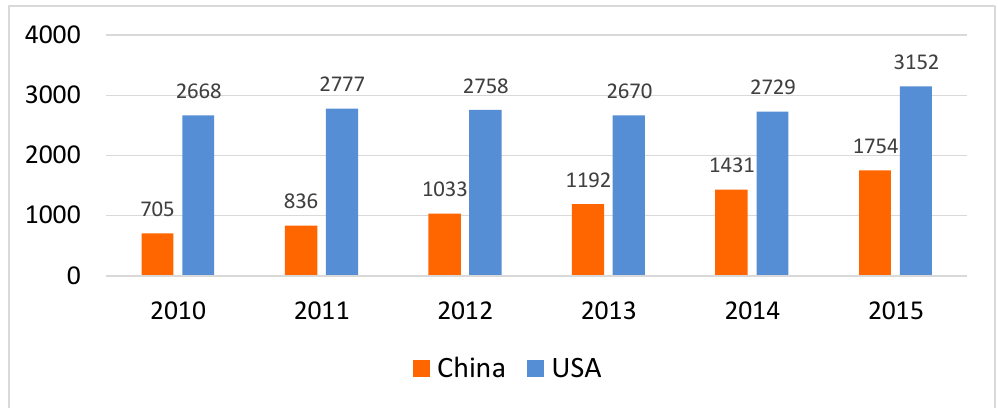
Figure 2. Number of published studies on diabetes research from China and the United States (Note: Based on a search of PubMed on 26/07/2017 using the search strategy in supplementary).